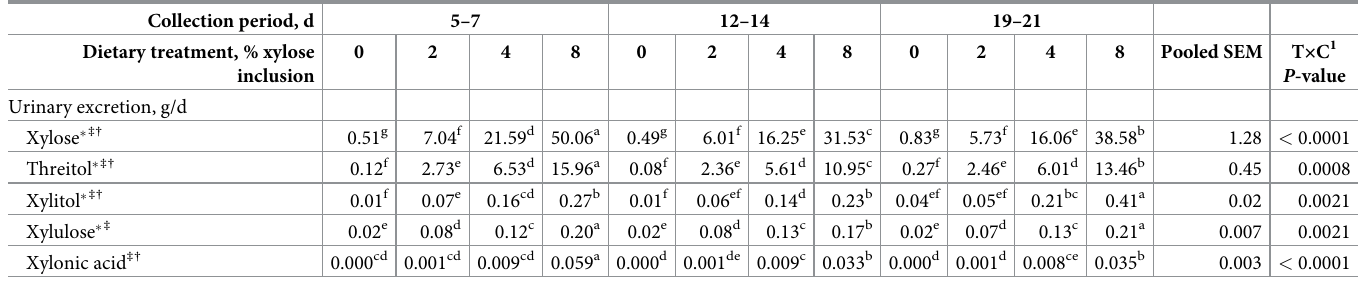
Table 7. Effect of dietary xylose concentration and collection period on urine xylose and metabolite excretion. Collection period, d